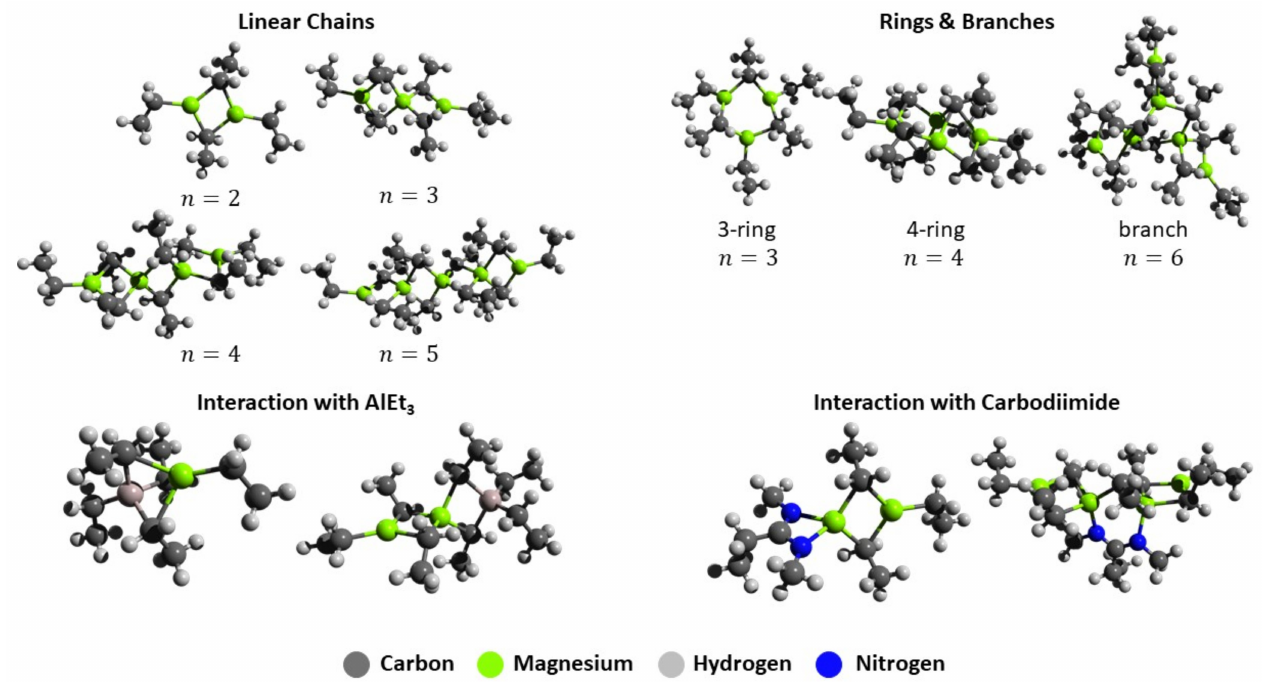
Figure 5. Visualization of the different magnesium alkyl oligomers and their clusters with additive molecules that were studied in this